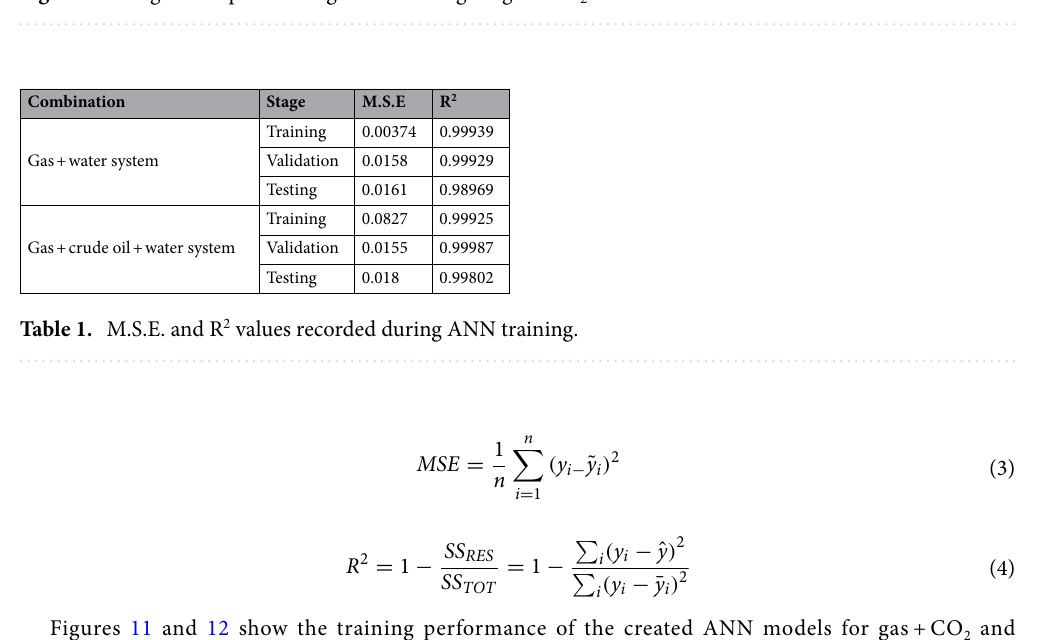
Figure 10. Regression plots during ANN training for gas + CO 2 + crude oil.